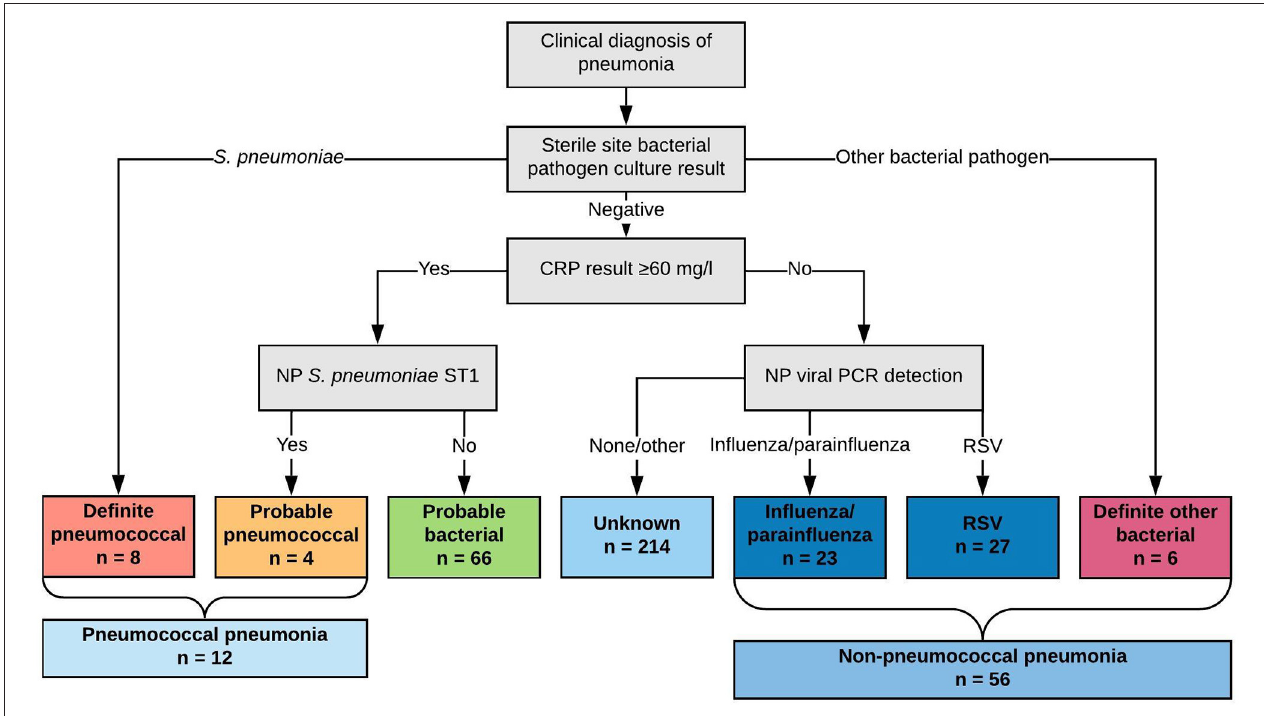
FIGURE 1 | Classification of children by likely etiology of pneumonia into comparator groups ( definite pneumococcal , probable pneumococcal , probable bacterial , unknown , influenza/parainfluenza virus , RSV , and definite other bacterial ) and by diagnosis of “ pneumococcal pneumonia ” and “ non-pneumococcal pneumonia ”.